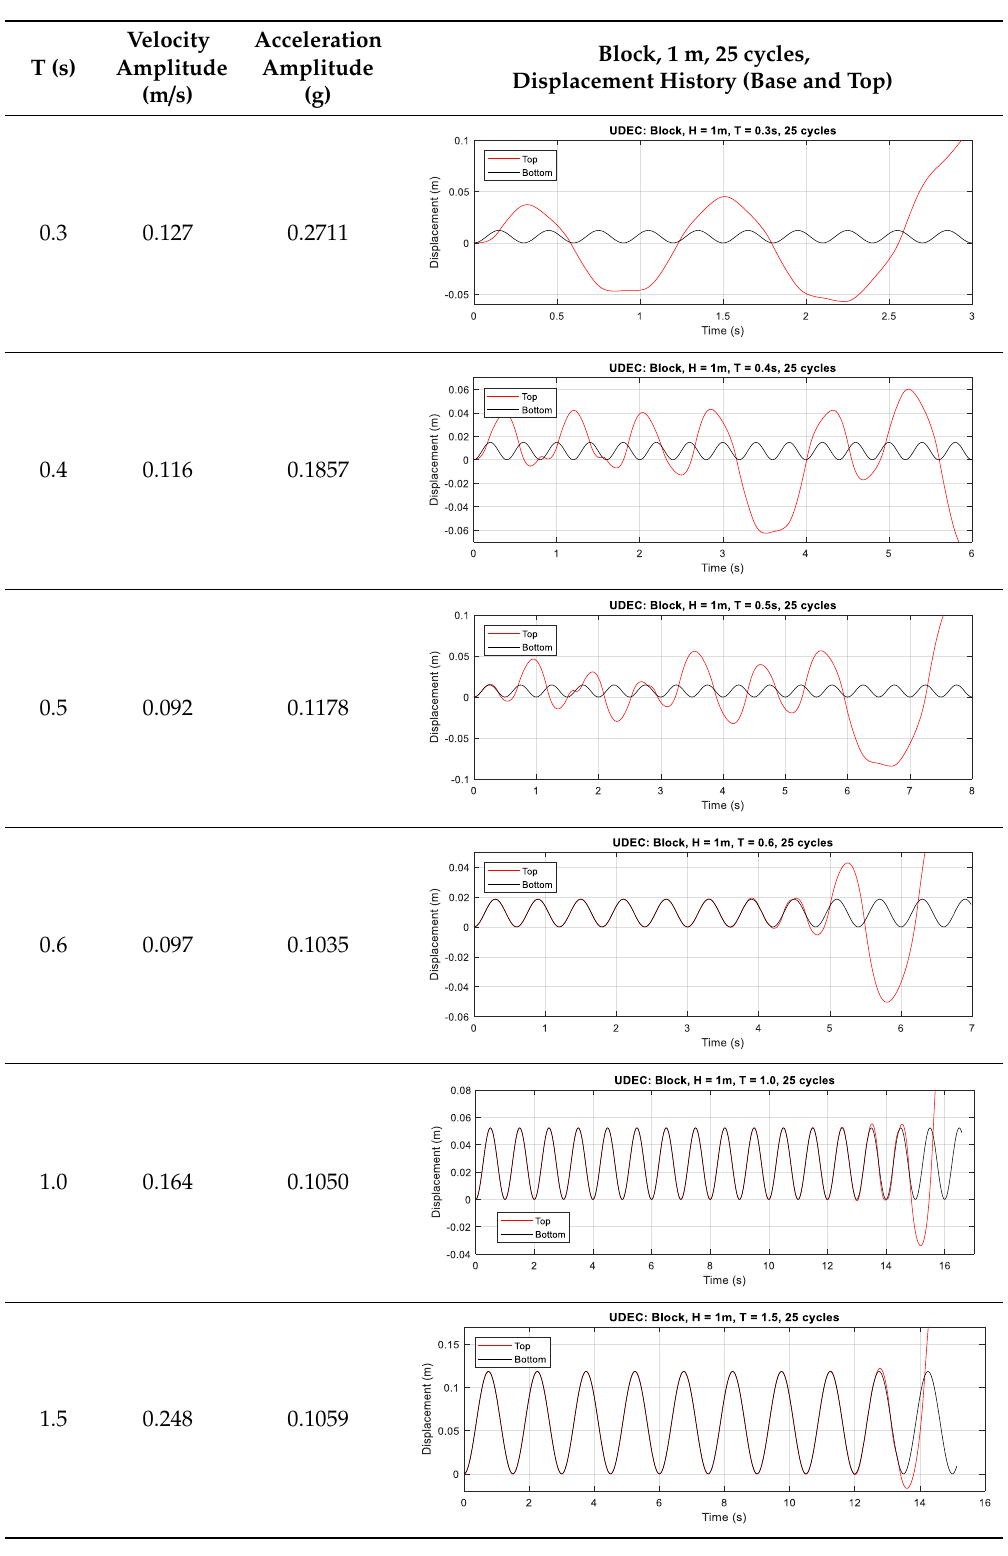
Table 2. Critical combinations for 1 m block UDEC